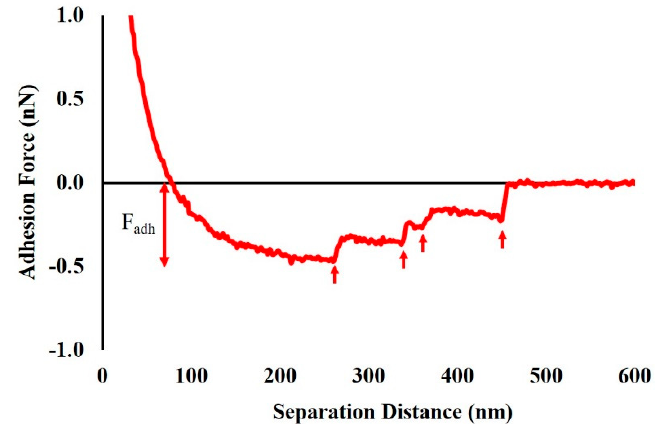
Figure 9. An example of a retraction force–distance curve measured between a Si 3 N 4 cantilever and the surface biopolymers of E. coli Strain A5 in DI water under tapping mode in the absence of ampicillin. The adhesion peaks (F adh ) on the retraction curve are indicated by red arrows. 3.10. Estimating the Length and the Grafting Density of a Bacterial Surface Biopolymer Brush using the